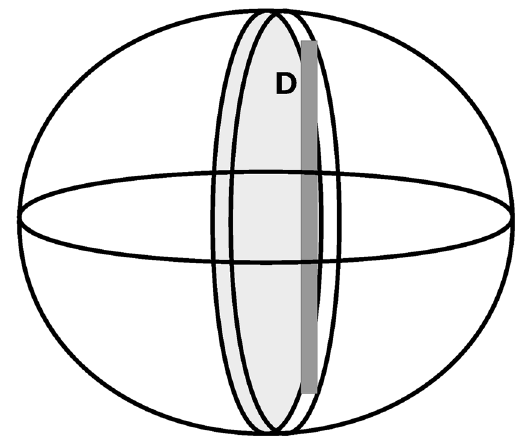
Figure 1. A sphere with the column-lenght drawn inside it The convolution of the approximate sum equation,